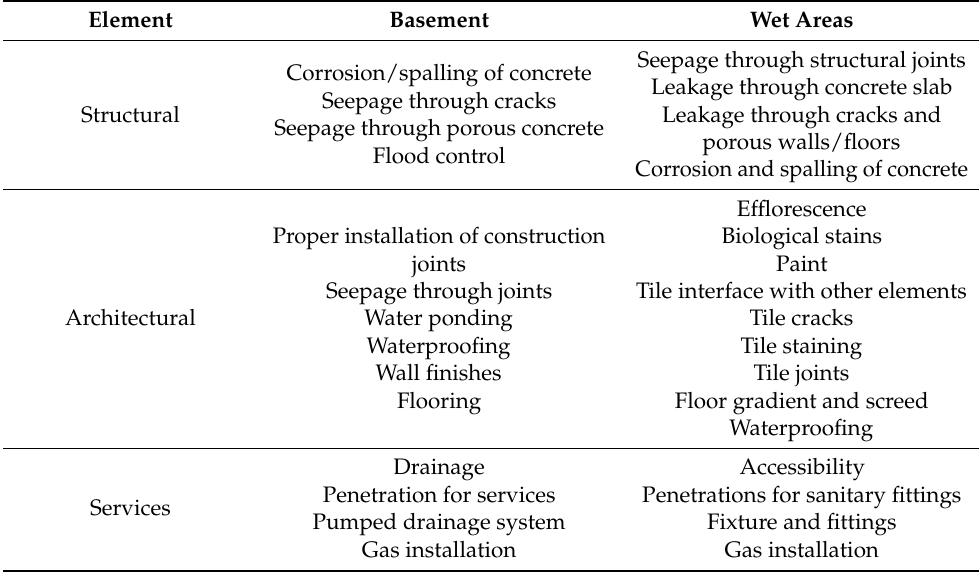
Table 1. Factors considered for case and field